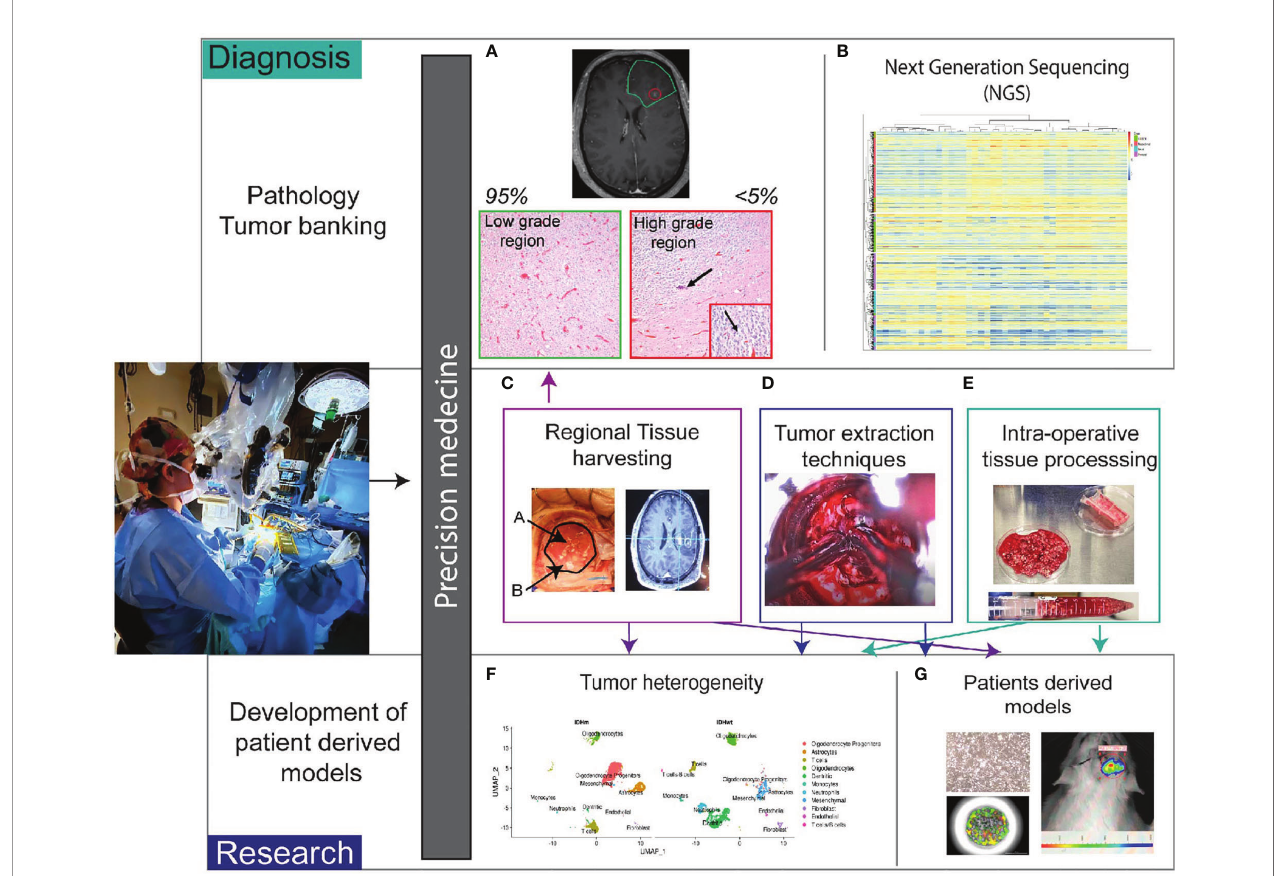
FIGURE 2 | Role of the neurosurgeon in biobank for precision medicine. (A) Patient tumors with heterogenous regions are sent separately to pathology. Non- enhancing region corresponds with low grade histopathologic features. Enhancing region (<5% of tumor in this case) correlates with high grade histopathologic features. Arrow in the image shows calci fi cation and the inset magni fi es region of high proliferation with the arrow denoting cells undergoing cell division. (B) Pathologic tissue is sent for next generation sequencing. Heatmap of glioblastoma gene expression pro fi les strati fi ed into classical, mesenchymal, neural and proneural subtypes. (C) Intraoperative tissue handling by the neurosurgeon involves regional harvesting utilizing MRI navigation (D) varied tumor extraction techniques such as non-thermal resection with specialized tools, and (E) intraoperative tissue processing with mechanical and chemical dissociation. (F) Once in the research laboratory, tissue can undergo single cell sequencing to determine heterogeneity. t-distributed stochastic neighbor embedding plots demonstrate differences between IDH mutant and IDH wildtype gliomas. (G) Tissue is also processed for patient derived models such as cell lines, organoids, and